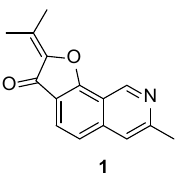
Figure 1. The fungal natural product TMC-120B ( 1 ).